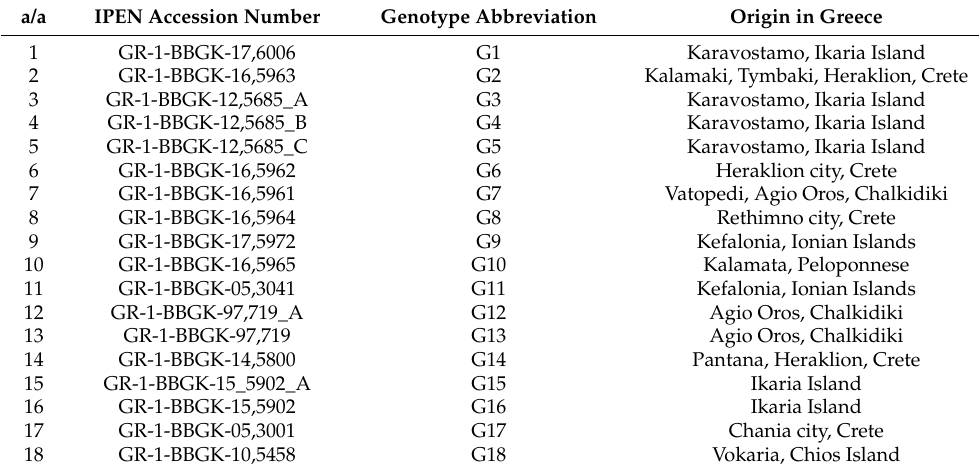
Table 1. Origin of the 18 native Greek rock samphire genotypes studied, with their IPEN (International Plant Exchange Network) accession numbers and their abbreviations.